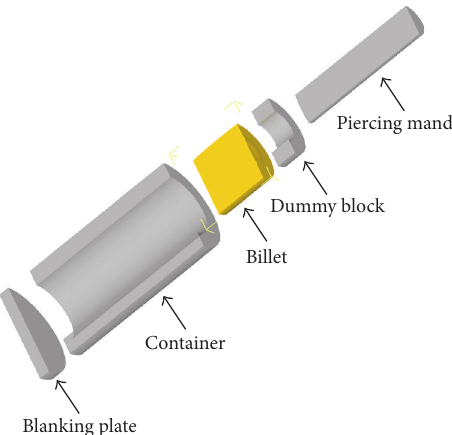
Figure 2: Structure components of a piercing extrusion die.